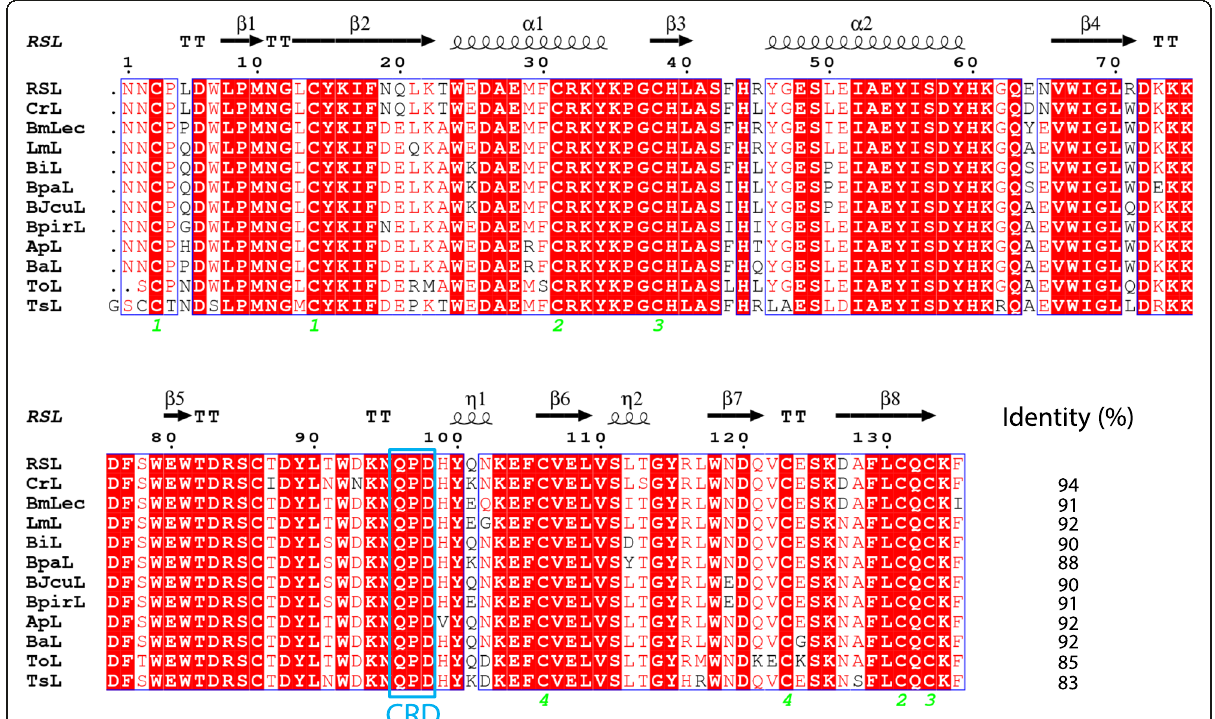
Fig. 1 Multiple alignment of SVgalL. The multiple alignment was performed using the program Clustal-X, and sequence similarities using ESPript 3.0 [73] with structure prediction based on RSL structure [PDB: 1JZN]. Fully conserved residues are highlighted in red background. Cystein residues involved in the interchain disulfide link are indicated by green numbers. Carbohydrate recognition domain (CRD) is indicated by the blue box. Primary structure according to lectins: RSL [GI: 126130], ApL [GI: 510120659], BaL [GI: 34922645], CrL [GI: 118572769], BiL [GI: 82126834], BmLec [24], BpalL [GI: 527504051], BJcuL [25], BpirL [GI: 510120660], LmL [GI: 1881829], ToL [27] and TsL [GI: